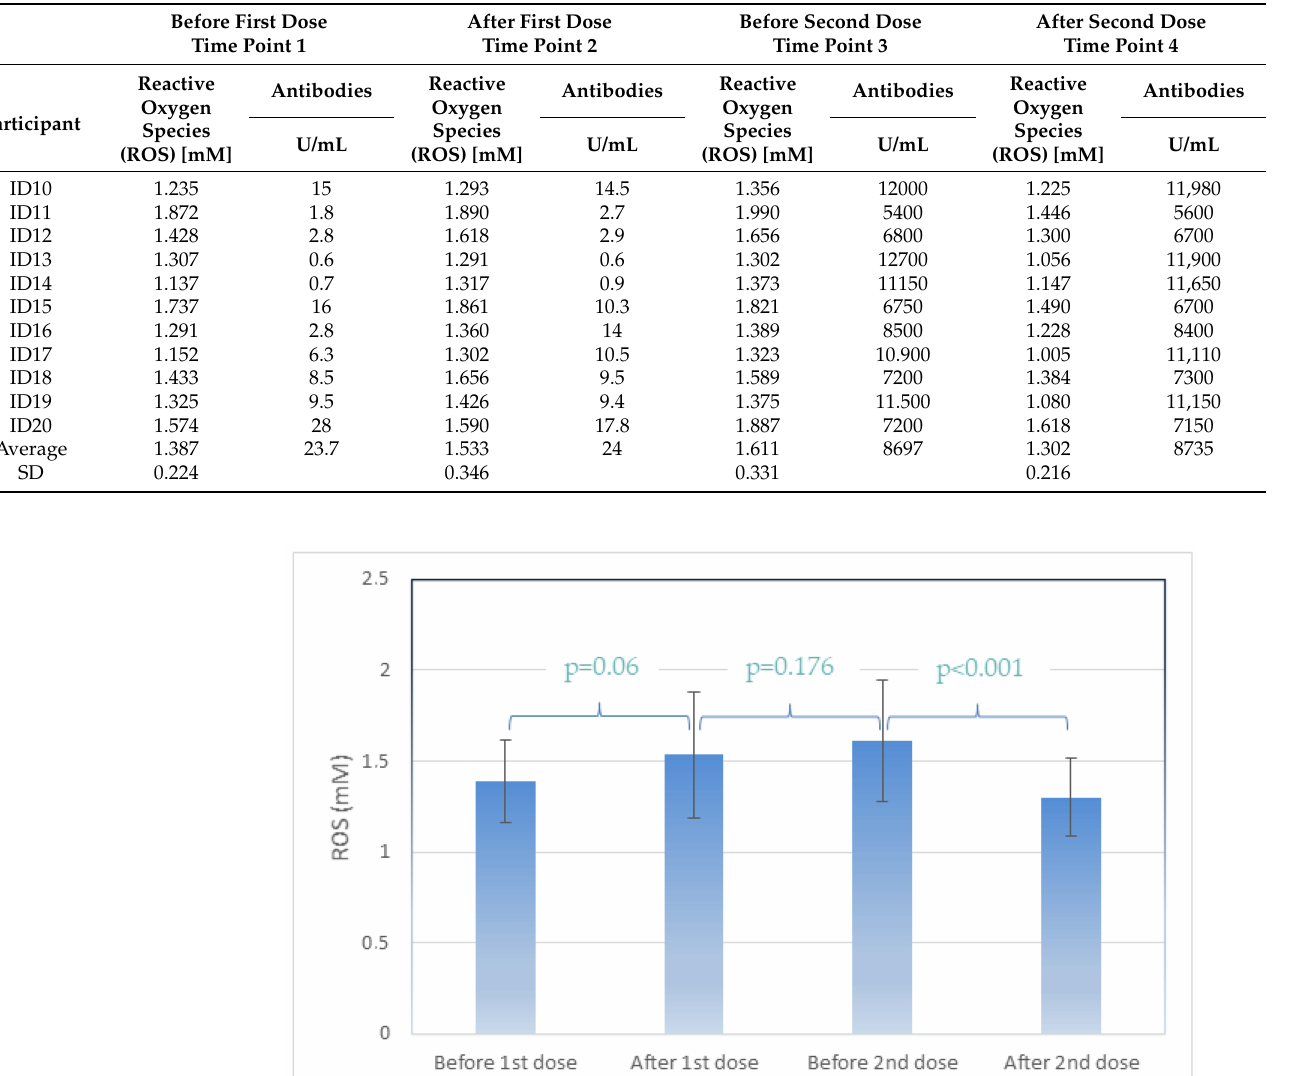
Figure 1. Average ROS (Reactive Oxygen Species) levels at the four timepoints. Data are represented as mean ( ±